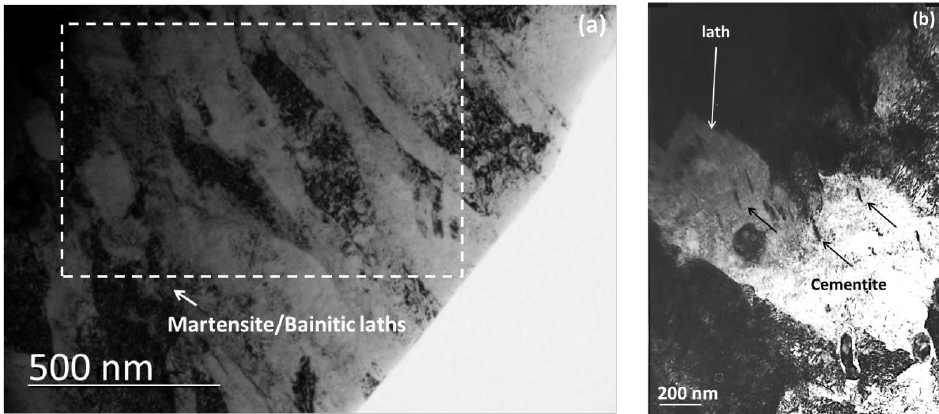
Figure 6. ( a ) TEM micrograph (bright field) of microstructure after UFHT. Martensite and bainitic ferrite laths have been identified. ( b ) TEM micrograph (bright field) showing lath in which fine elongated cementite has been precipitated.